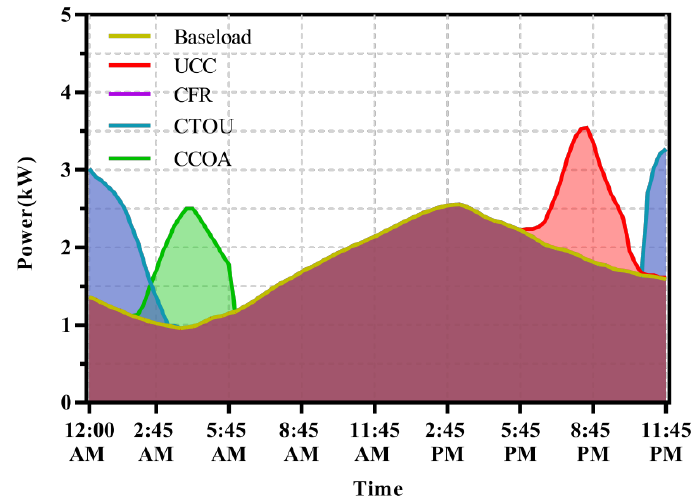
Figure 7. Electric load profiles concerning UCC, CFR, CTOU, and CCOA charging